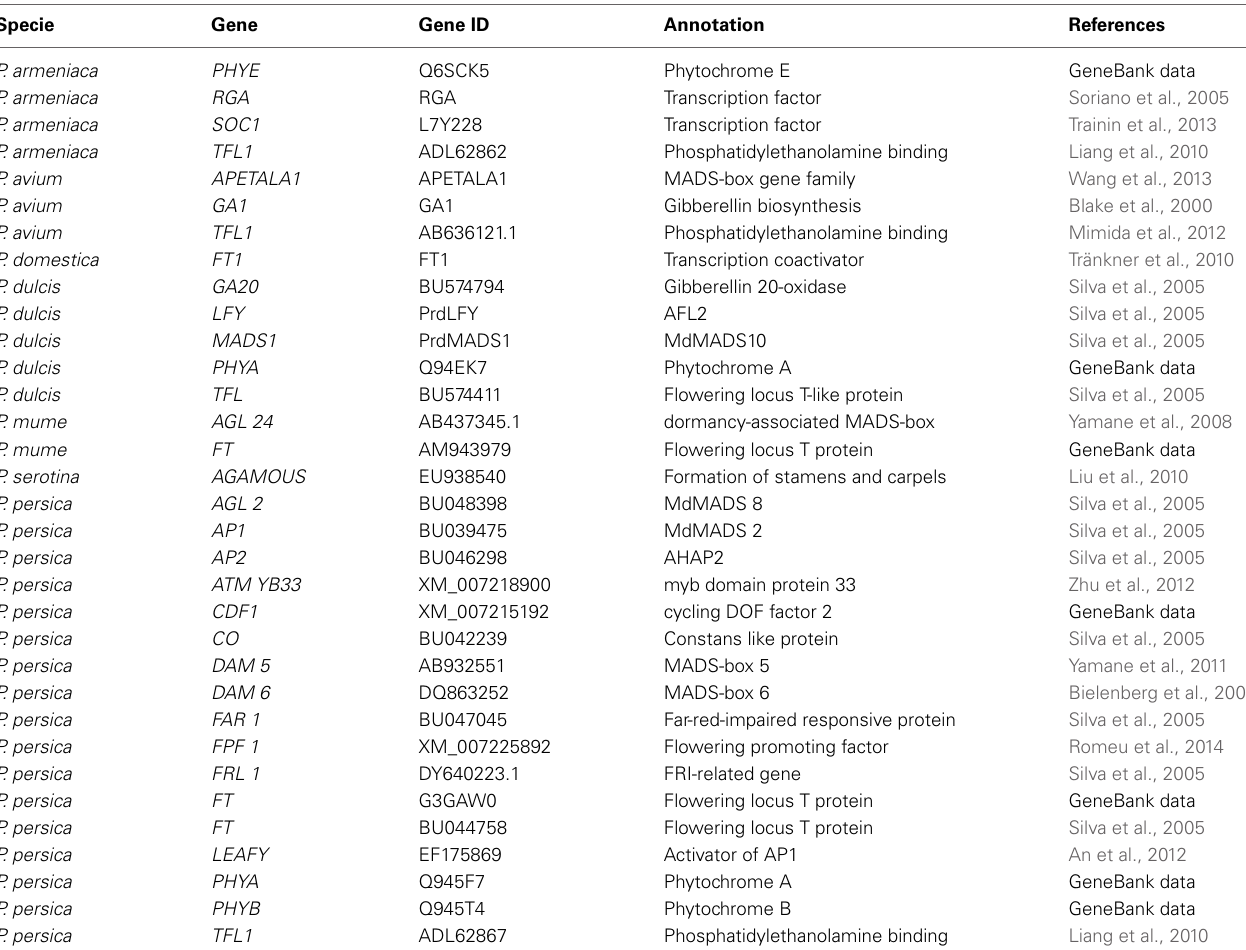
Table 1 | Identified genes involved in the regulation of flowering time in Prunus species.